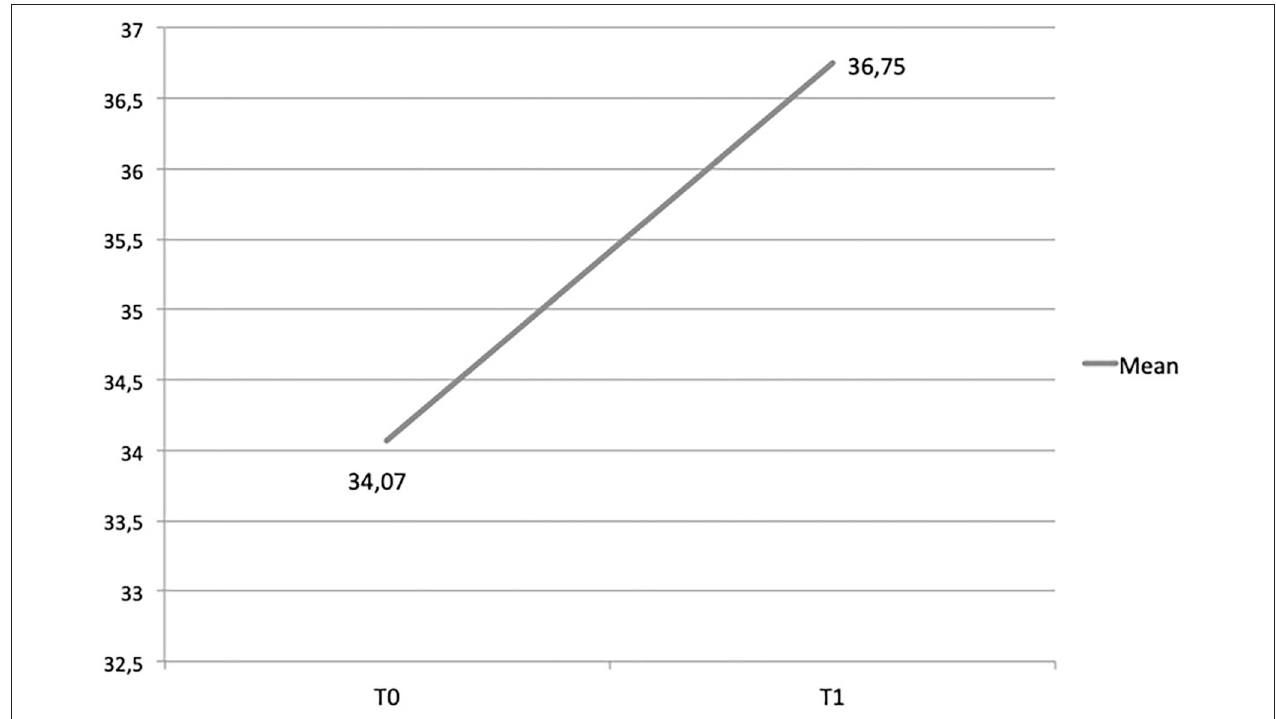
FIGURE 2 | Trainees’ knowledge of resilience and its application to psychosocial interventions.